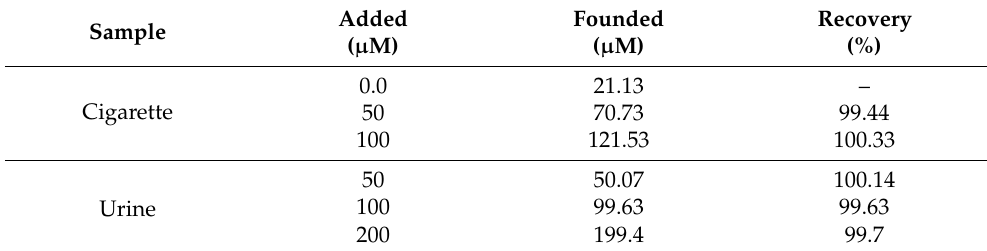
Table 2. Detection of NIC in practical samples at the